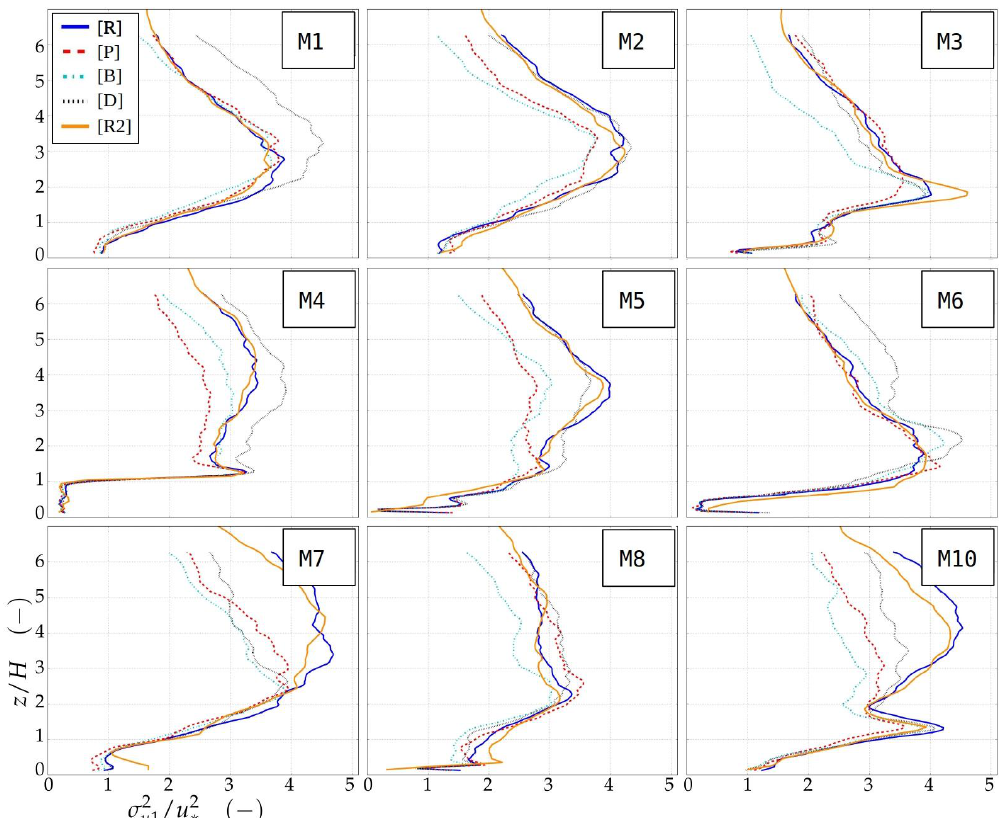
Figure 11. Local vertical plots of streamwise velocity variance σ 2 sites: The contribution of statistically insufficiently described very-large-scale turbulence motions is distinctly visible above the urban